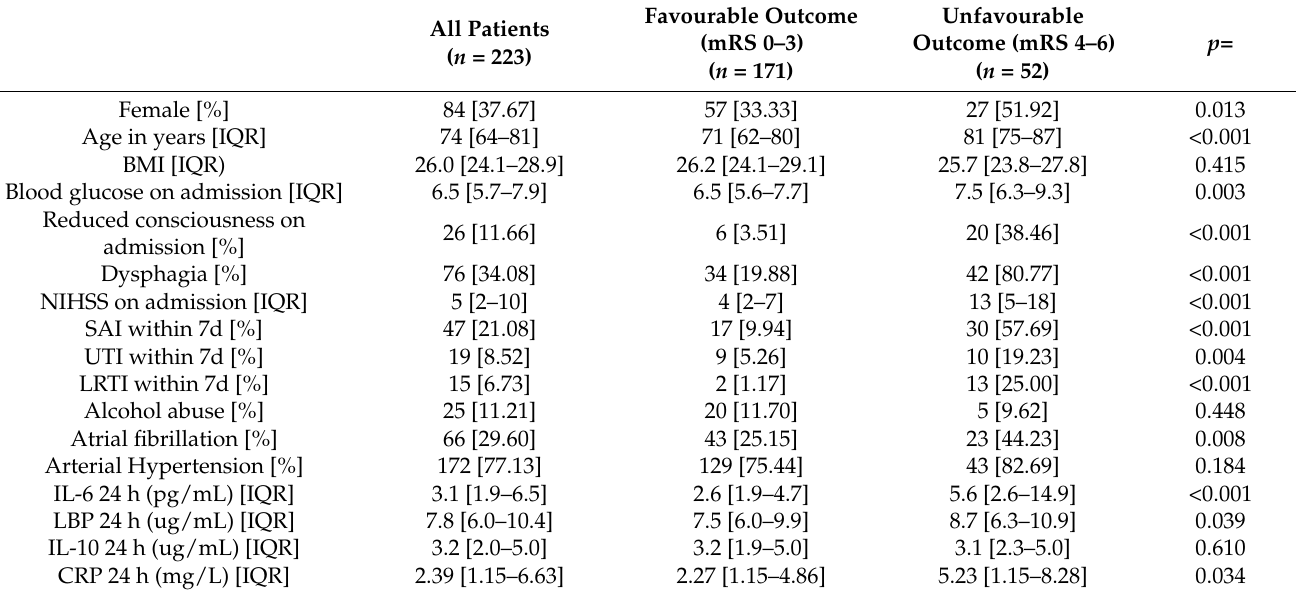
Table 2. Distribution of the Patient Characteristics According to the mRS Status at